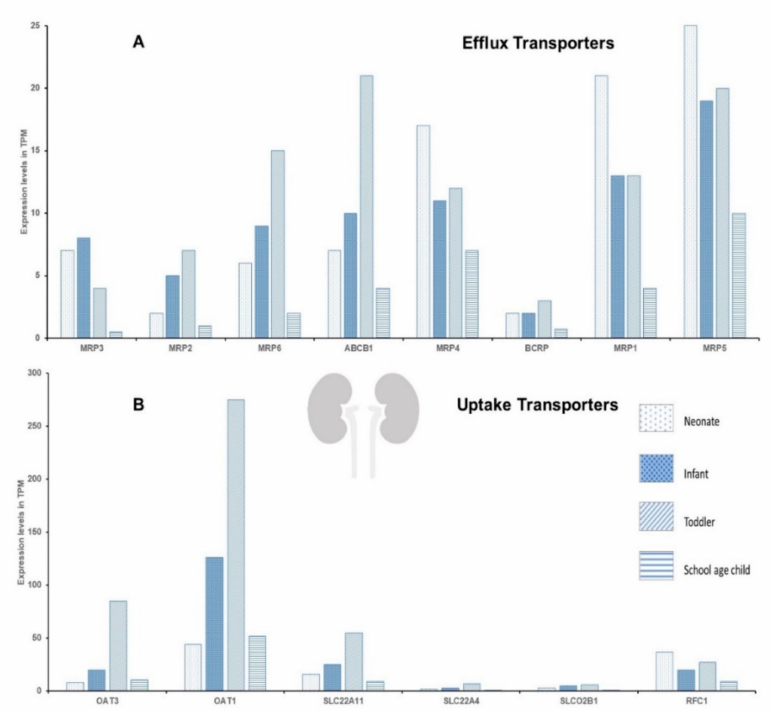
Figure 4. The mRNA expression of some of the key renal efflux ( A ) and uptake ( B ) transporters. The y -axis denotes expression levels in transcript per million (TPM). The data were collated and adopted from EMBL-EBI Available online: https://www.ebi.ac.uk/gxa/home (accessed on 27 June 2022)